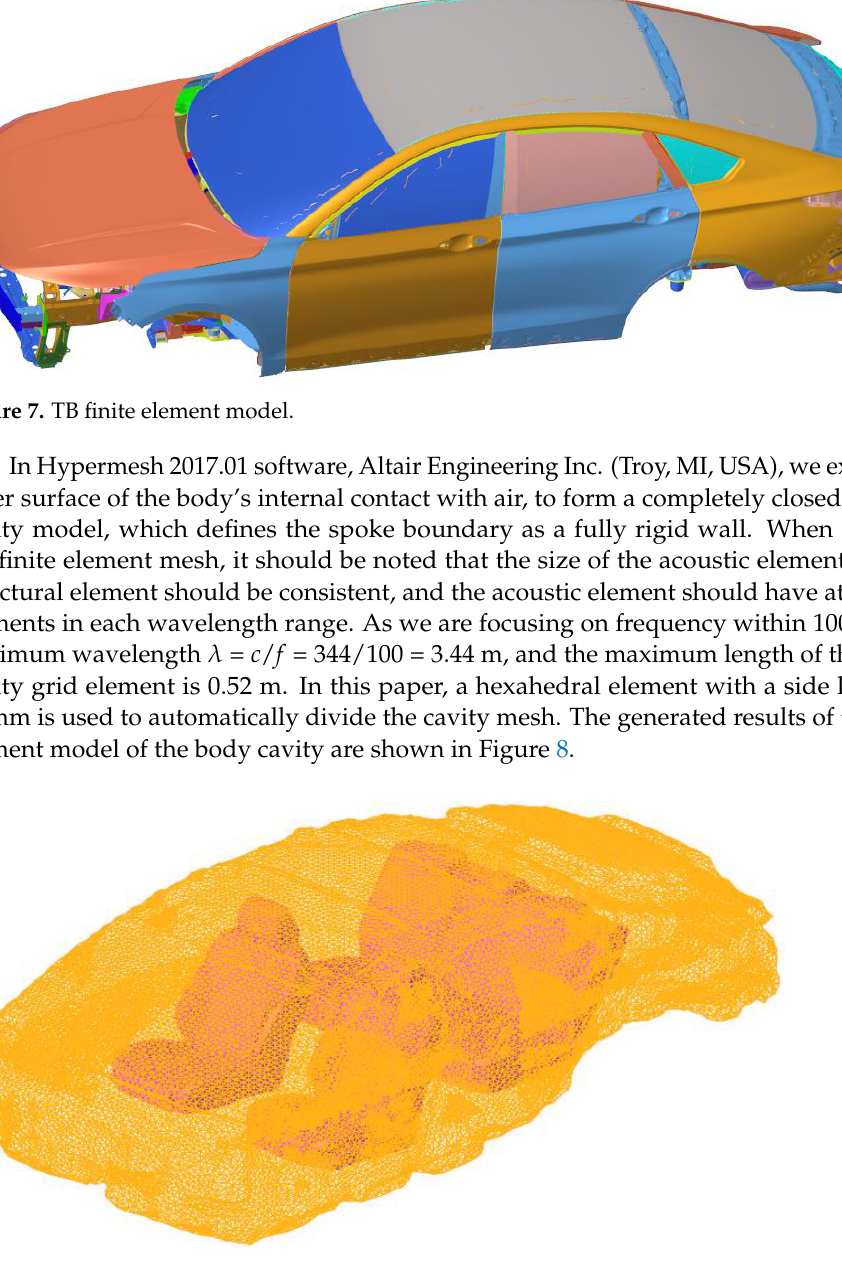
Figure 8. Acoustic cavity finite element model.